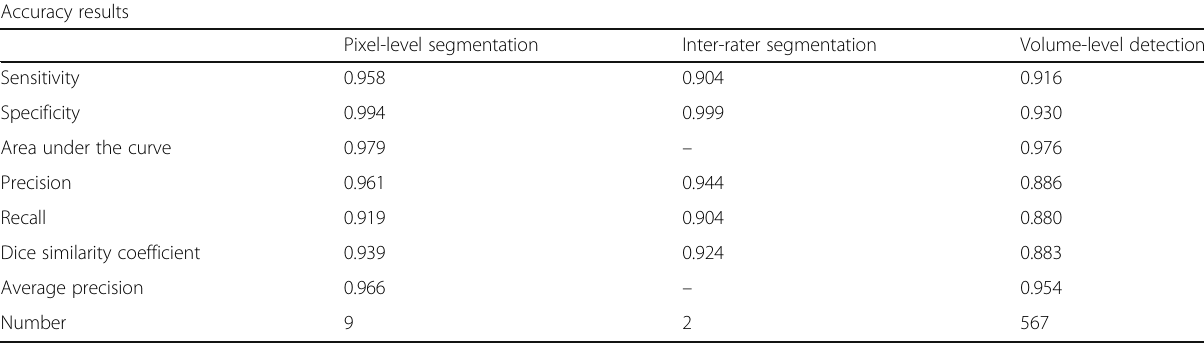
Table 2 Accuracies for the segmentation of a pneumothorax at the pixel level, detection of a pneumothorax at the volume level, and between radiologists, is displayed in terms of sensitivity, specificity calculated at the Youden index of the receiver operating characteristic curve and corresponding area under curve as well as precision, recall, and Dice similarity coefficient calculated at the optimal cut-off point of the precision-recall curve, and corresponding average